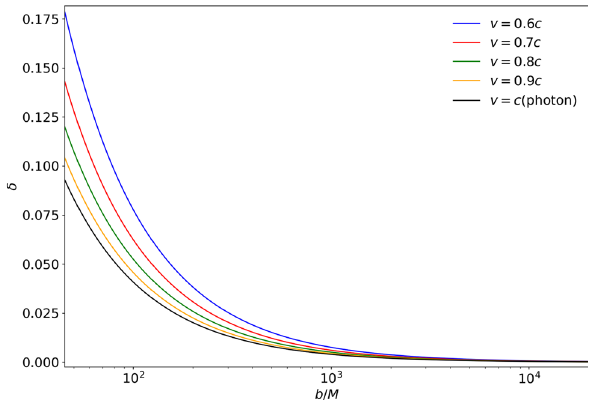
Fig. 4 The finite-distance weak gravitational deflection angle of mas- sive particles in Brahma–Chen–Yeom rotating black hole. r S = r R = 10 8 M , a = 0 . 5 M , λ = 0 . 1. We choose a large initial impact parameter since Eq. (37) is a second-order post-Newtonian result for the weak gravitational